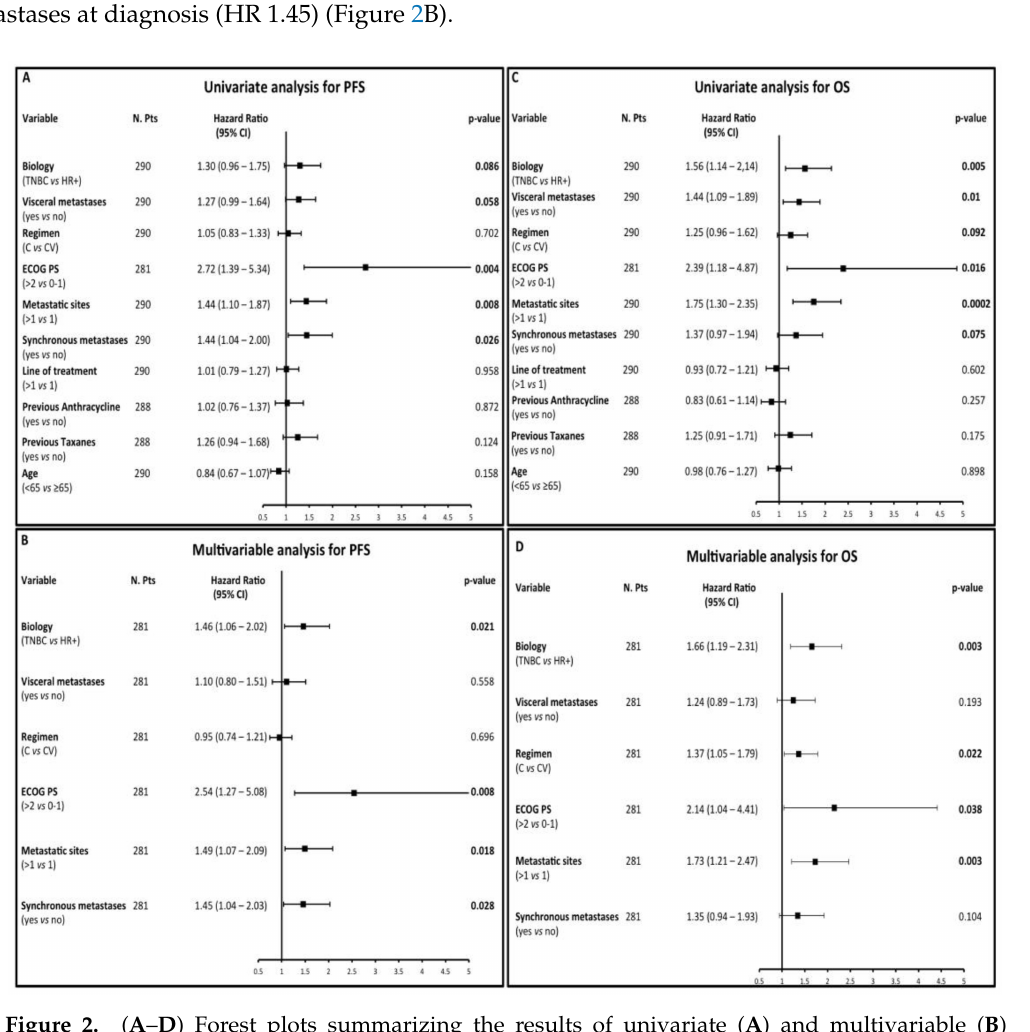
Figure 2. ( A – D ) Forest plots summarizing the results of univariate ( A ) and multivariable ( B ) analysis of patient progression-free survival (PFS) according to the treatment received and other meaningful covariates, as well as of univariate ( C ) and multivariable ( D ) analysis of patient overall survival (OS) according to the treatment received and other relevant covariates. C: capecitabine; CV: